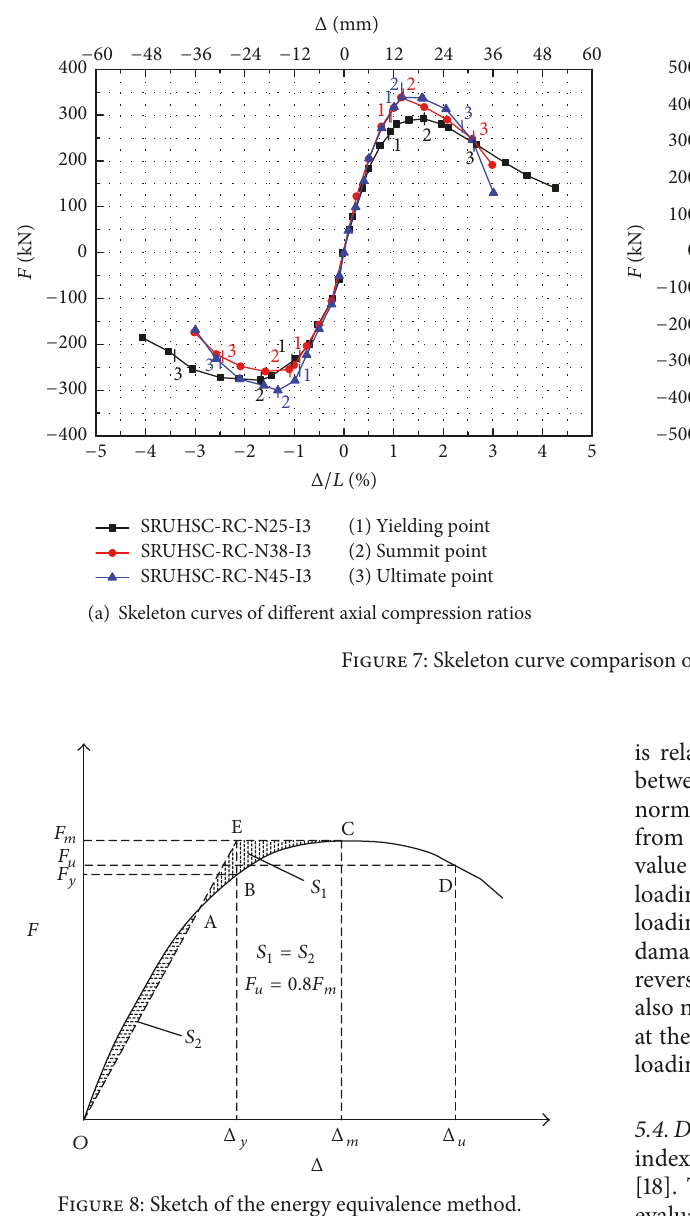
Figure 8: Sketch of the energy equivalence